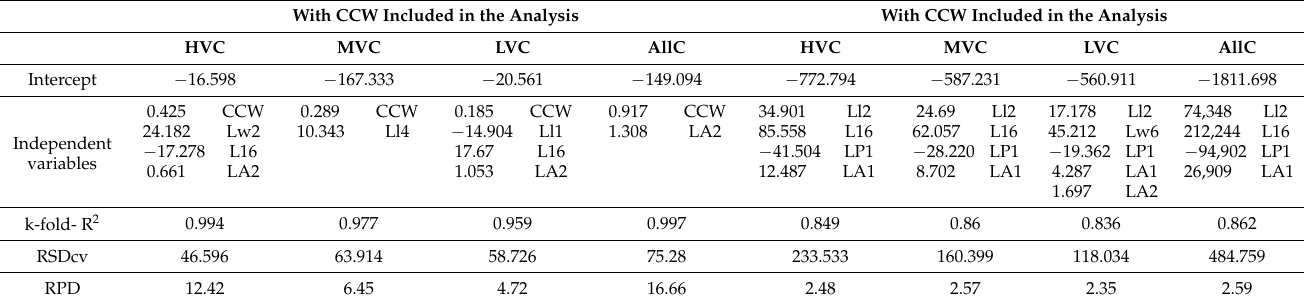
Table 3. Equations and corresponding coefficient of determination k-fold (k-fold-R 2 ), residual standard deviation of the cross-validation (RSDcv) and ratio of prediction to deviation (RPD) for the prediction of cut weight with and without cold carcass weight (CCW) included in the analysis ( n = 55).